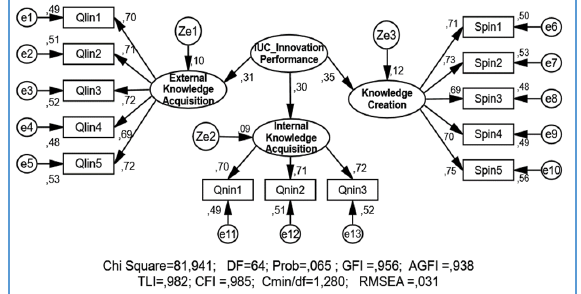
Fig. 2. Second-order CFA IUC-Innovation